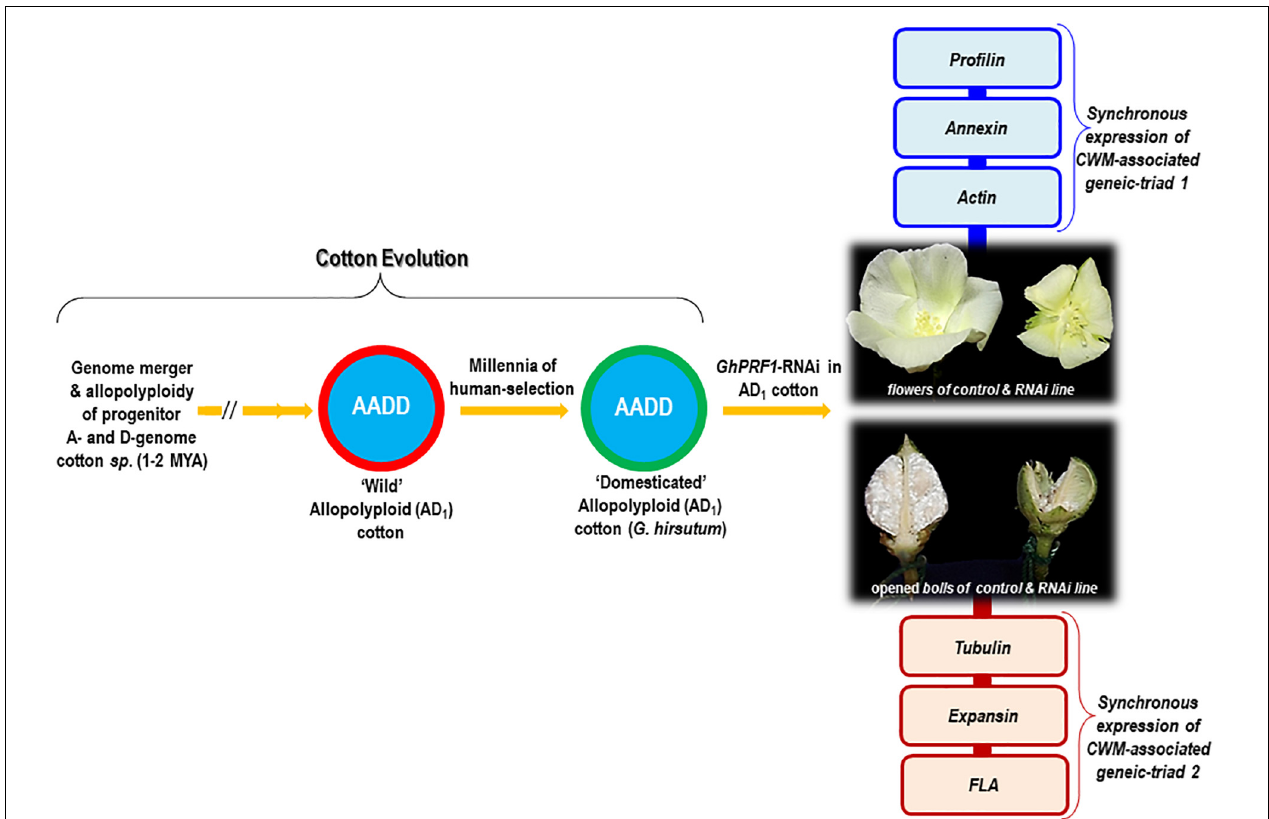
FIGURE 1 | Summarized representation of cell wall-modifying (CMW) gene expression evolution accompanying the evolutionary trajectory of genomic merger and allopolyploid formation in cotton. RNAi of the GhPRF1 gene showed abnormal floral shapes and reduced fiber development in mature bolls. Relative temporal expression of the “ GhPRF–GhAnnex–GhAct ” and “ Tub-Exp-FLA1 ” geneic-triads at the 5-, 10-, and 20-dpa stages of fiber development in the Coker 310 cultivar exhibits synchronous expression patterns and highlights their fine-scale coordination during floral and fiber